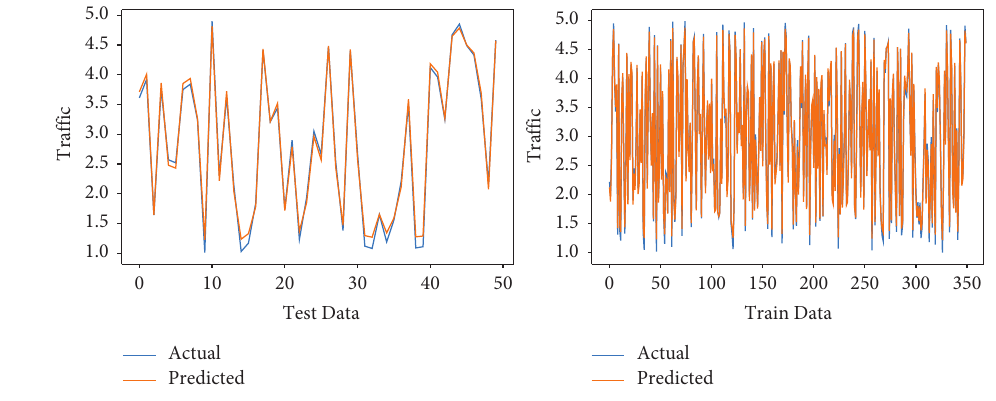
Figure 12: Processing for test data in the SVR method. Table 4: Quantitative comparison of